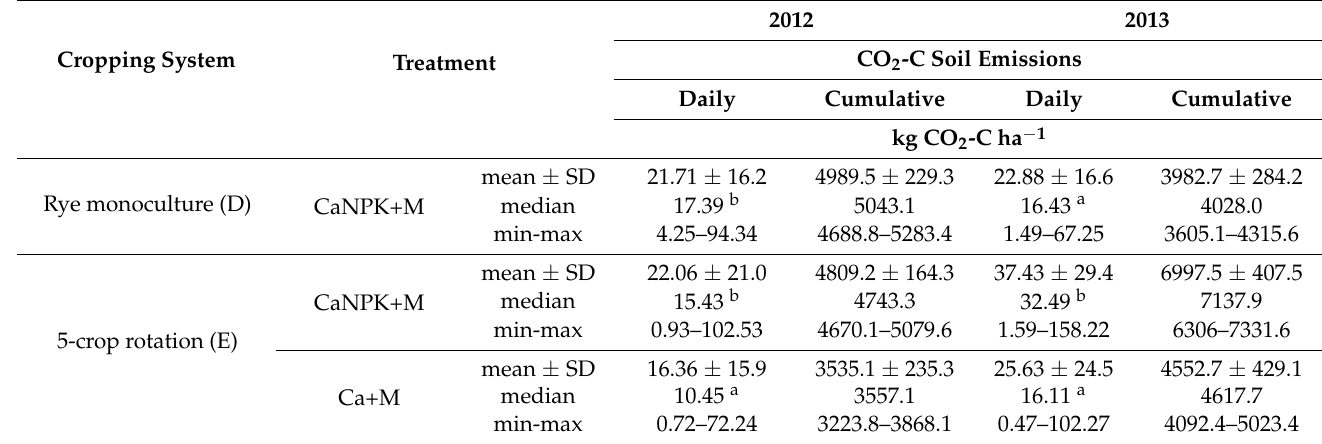
Table 3. Daily and cumulative CO 2 -C emissions from soil on Ca+M and CaNPK+M treatments under rye monoculture and 5-crop rotation experiments over the measurement period in 2012 and 2013.